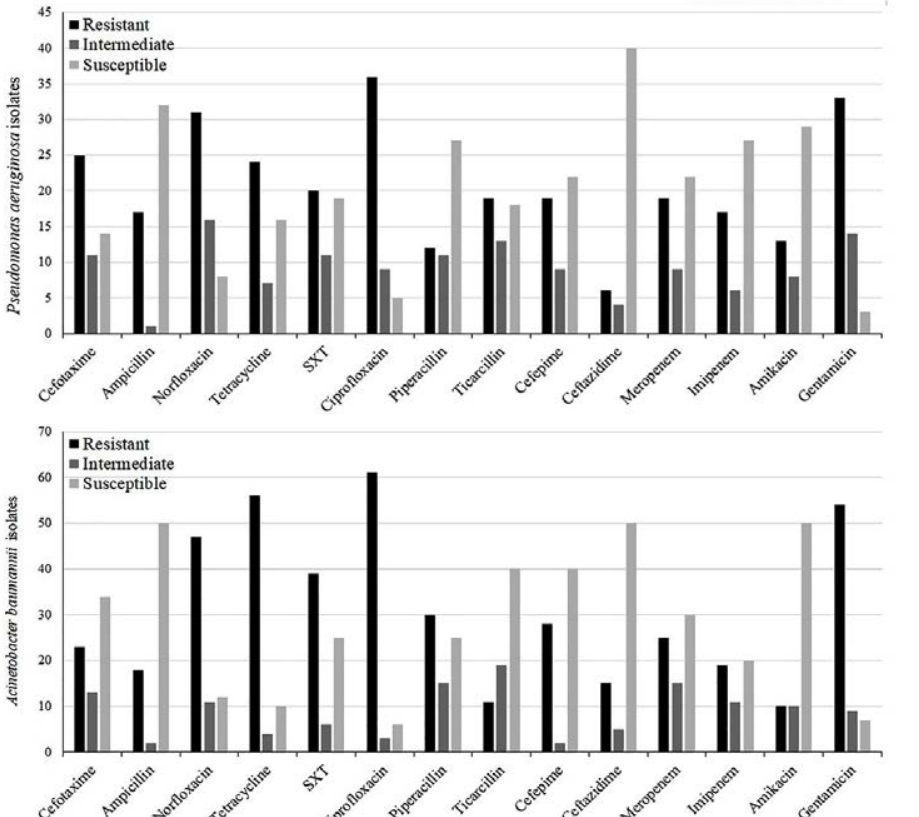
Fig. 1. Antibiotic resistance pattern in clinical isolates of P. aeruginosa and A.